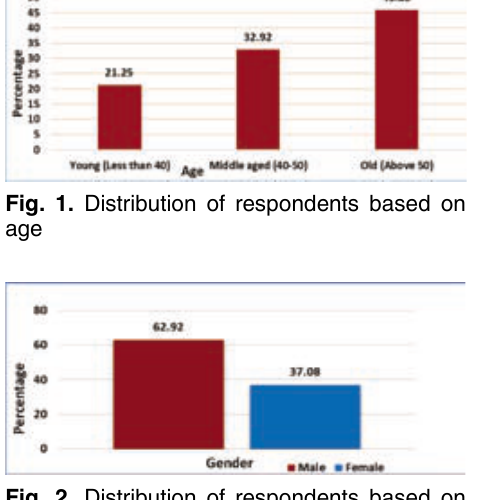
Fig. 2. Distribution of respondents based on Gender